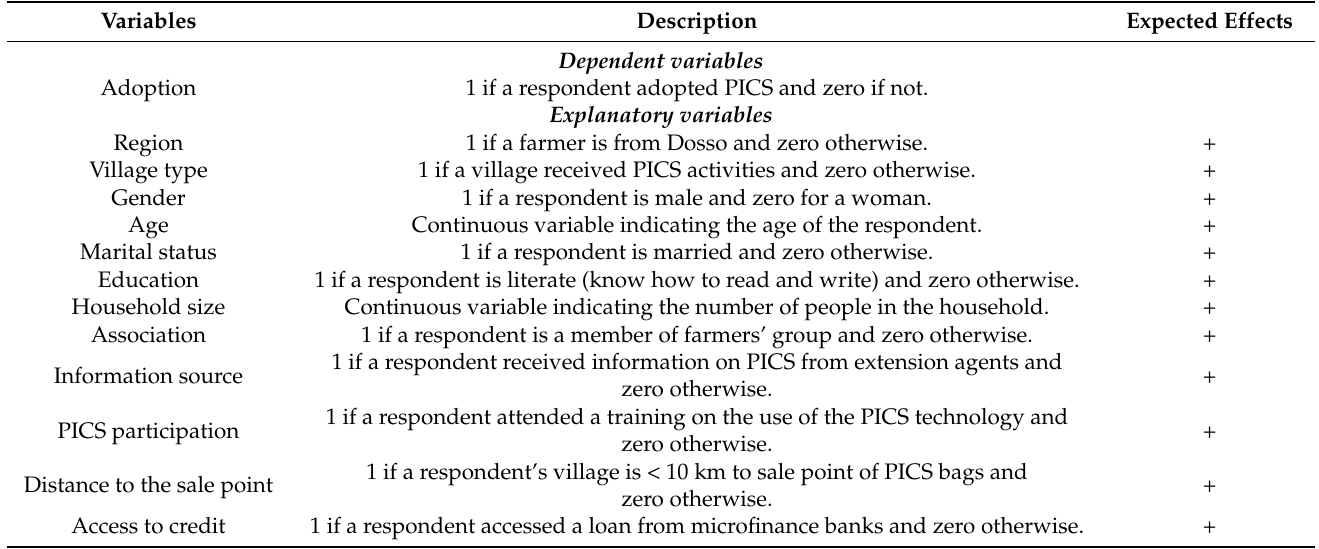
Table 1. Description of variables used in the logit regression